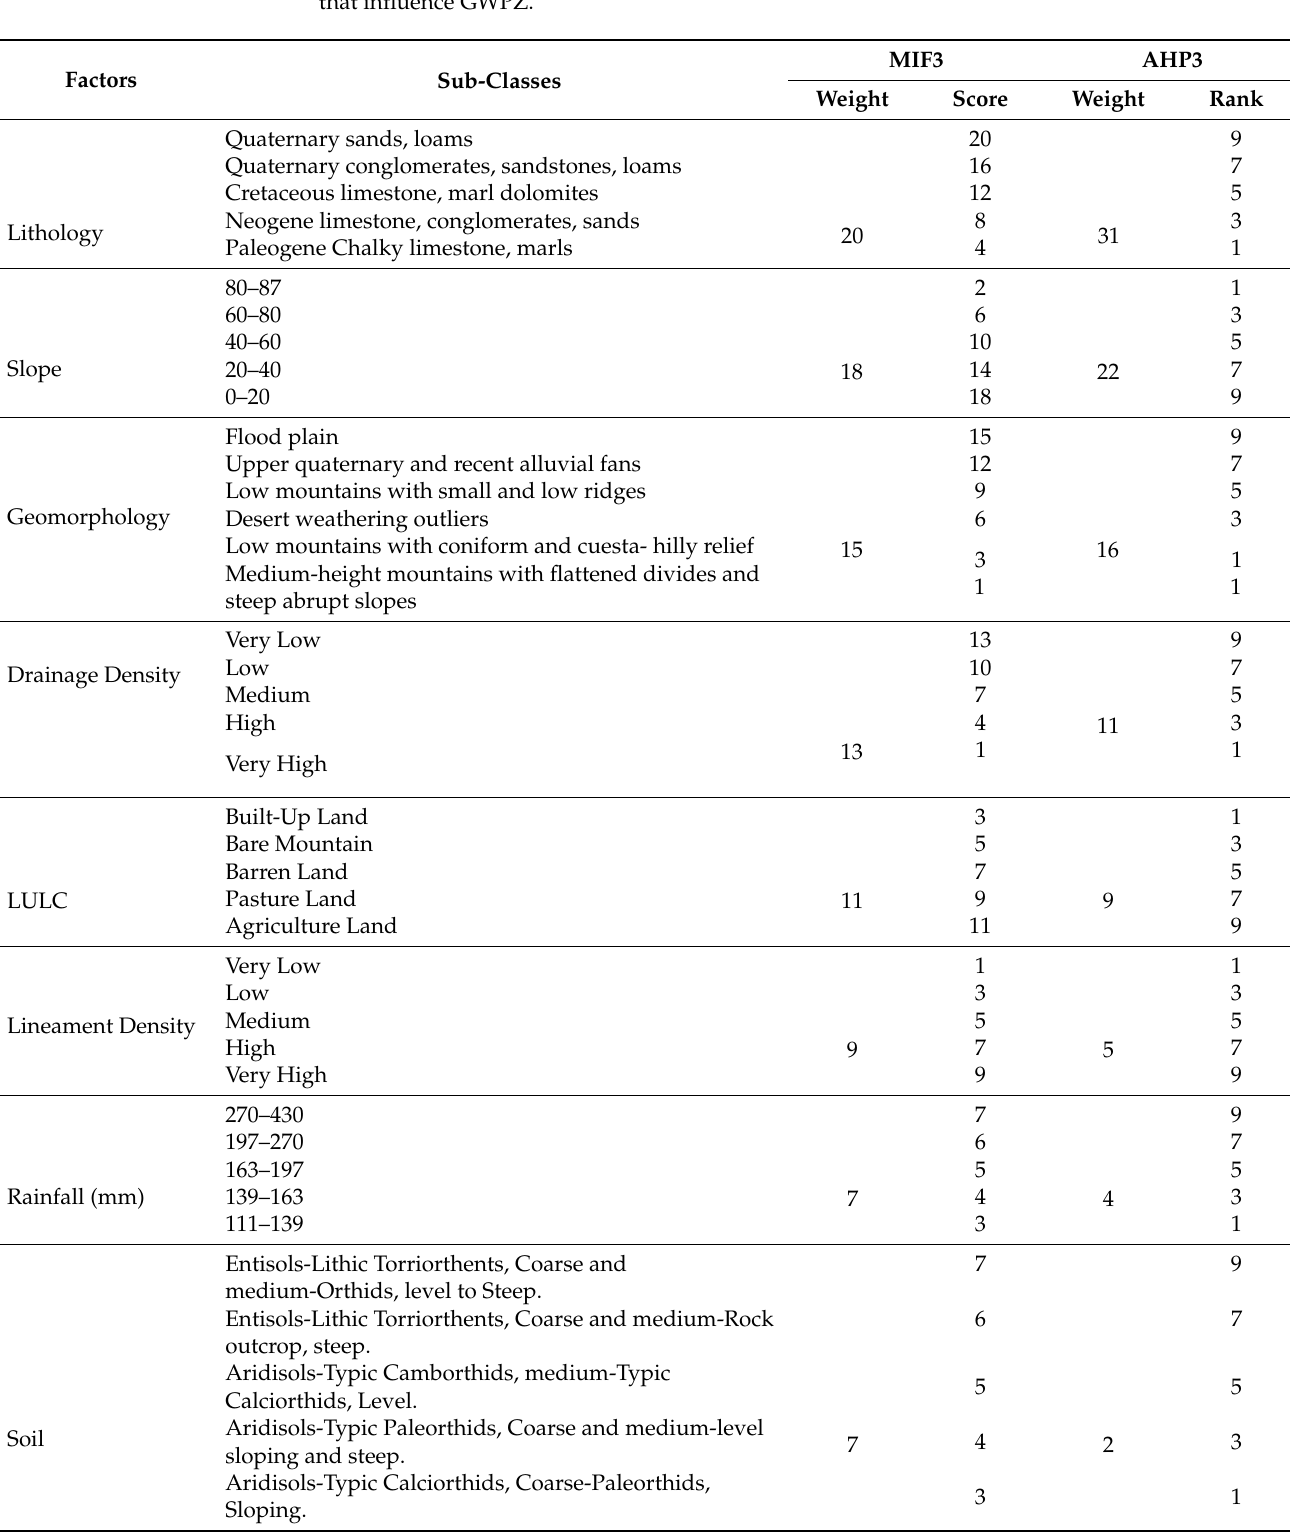
Table A3. Weight and scores of specific characteristics in (MIF3 and AHP3) are assigned to factors that influence